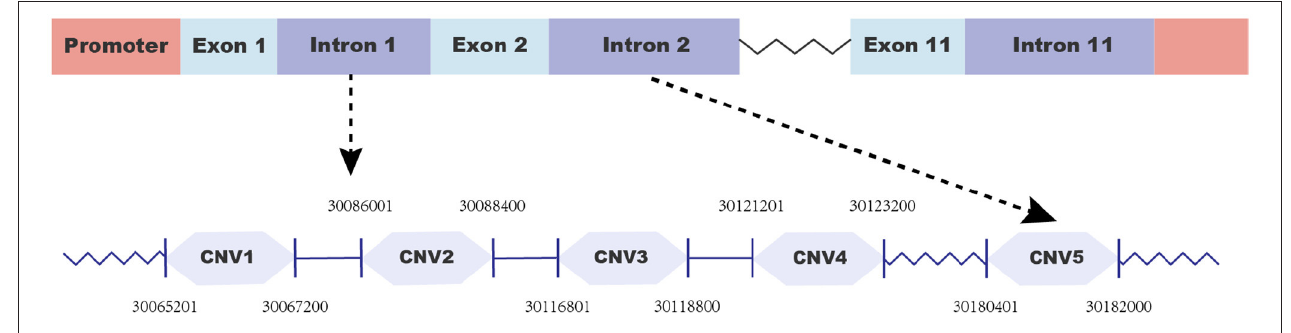
FIGURE 1 | Gene structure of the goat Fec B gene.